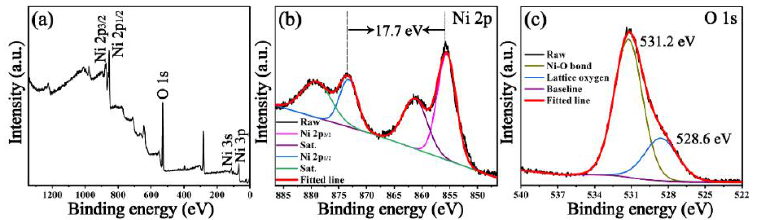
Figure 2. XPS spectra of ( a ) survey spectrum; high resolution of ( b ) Ni 2p and ( c ) O 1s for Ni(OH) 2 - 36.